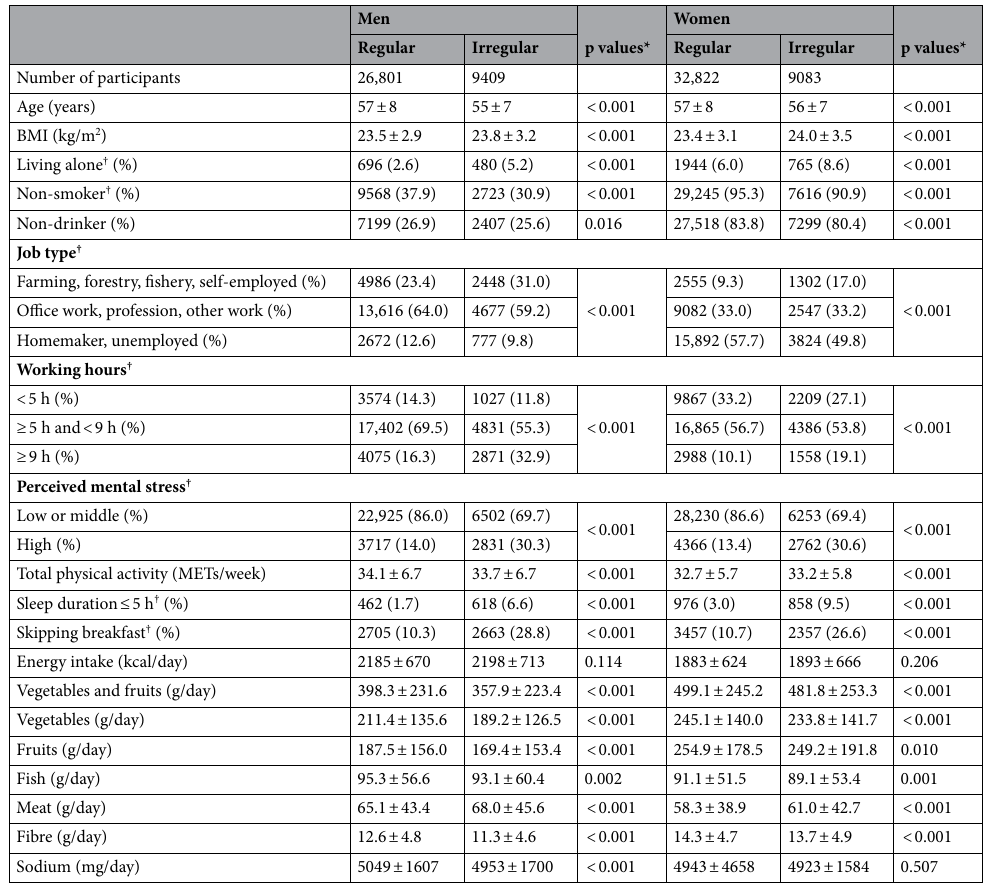
Table 1. Baseline characteristics according to self-reported irregular daily routine. Values are expressed as mean ± standard deviation or number (%). *Determined by t-test or Chi-square test. † Participants with missing information were excluded (living arrangement n = 1485; smoking status: n = 4981; job type: n = 13,737; working hours: n = 6462; perceived mental stress: n = 529; Sleep duration: n = 345; skipping breakfast: n = 1425). BMI body mass index, MET metabolic equivalent